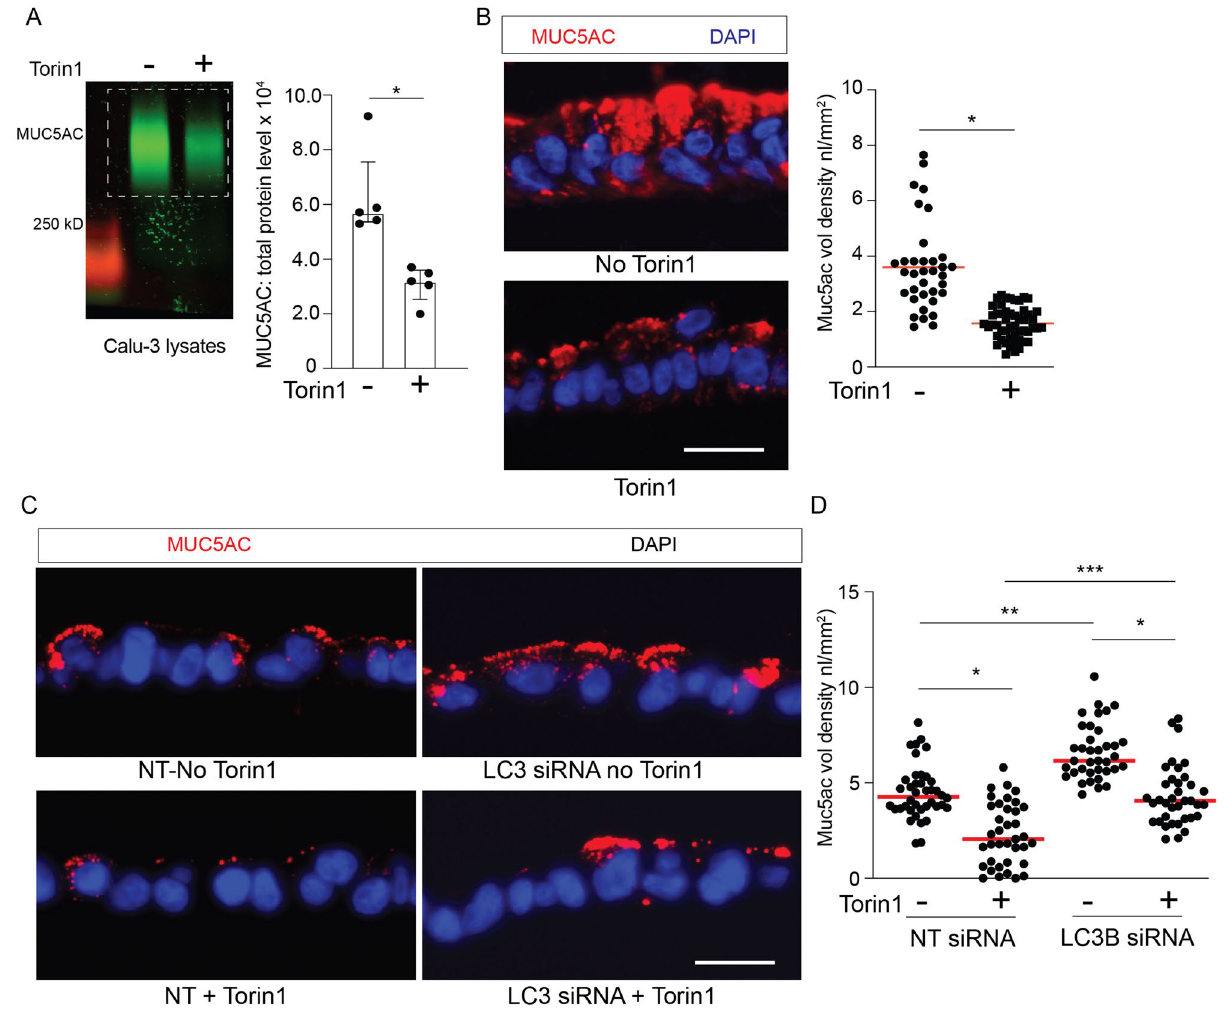
Figure 8. Activation of autophagy leads to decreased intracellular MUC5AC granules in human airway epithelial cells. ( A ) Representative immunoblot of MUC5AC from cell homogenates from Calu-3 treated ± torin1 (10 μM) for 18 h with corresponding quantification by total protein levels (N = 7 per group). ( B ) Representative MUC5AC immunostaining in Calu-3 cells under ALI conditions ± torin1 treatment. Scale bar = 25microns. Corresponding quantification of MUC5AC staining volume density. N = 3 experiments with 10–20 microscope images taken per sample. ( C ) Representative MUC5AC immunostaining of Calu-3 transfected with NT or LC3B siRNA and treated ± Torin1 (10 μM) for 18 h with corresponding quantification ( D ) of MUC5AC volume density. Scale bar = 25microns. N = 2 experiments with 20 microscope images taken per sample. Graphs show scatter plots with median bar for mucin immunostaining and scatter plots with median bar and interquartile range for mucin blots. Significant difference by Mann–Whitney test with * for torin1 difference for MUC5AC blot in part ( A ) and unpaired T-test for MUC5AC immunostaining in part B . For quantification of parts ( C , D ) significant difference by ANOVA with Tukey’s post-hoc comparisons are noted by * for torin1 treatment difference or ** and *** for siRNA (Fig. S5C), rather Torin1 reduced intracellular MUC5AC protein levels detected by mucin immunoblotting and immunostaining (Fig. 7A,B). The effect of Torin1-mediated reduction in intracellular MUC5AC granules was mitigated when LC3B was depleted by siRNA (Fig. 8A–D). We next looked at human AECs under ALI conditions. There was a significant decrease in MUC5AC levels in torin1 treated human AECs (Fig. 9A,B) and in COPD derived AECs (Fig. 9C,D). We measured the secreted MUC5AC from Calu-3 cells or human AECs under ALI conditions. Autophagy activation by mTOR inhibition with Torin1 led to a decrease in secreted MUC5AC consistent with the cell lysate findings and showing that Torin1 did not induce mucin secretion (Fig. S5D–F). These findings indicate that intracellular MUC5AC granules can be reduced by the activating the autophagosome-lysosome pathway.